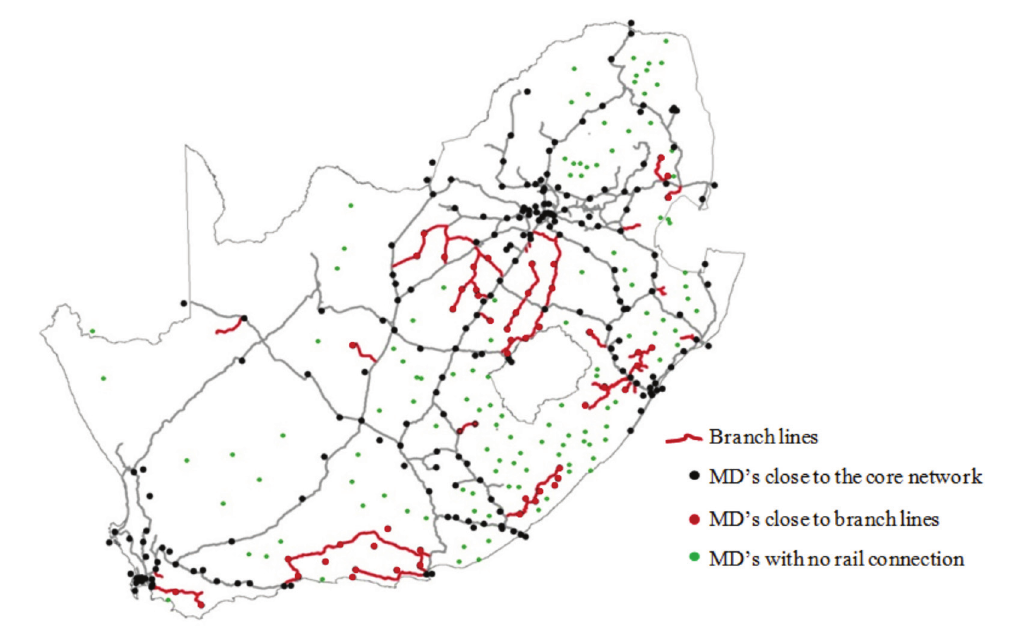
Figure 1: The relationship between magisterial districts and branch lines on the South African railway